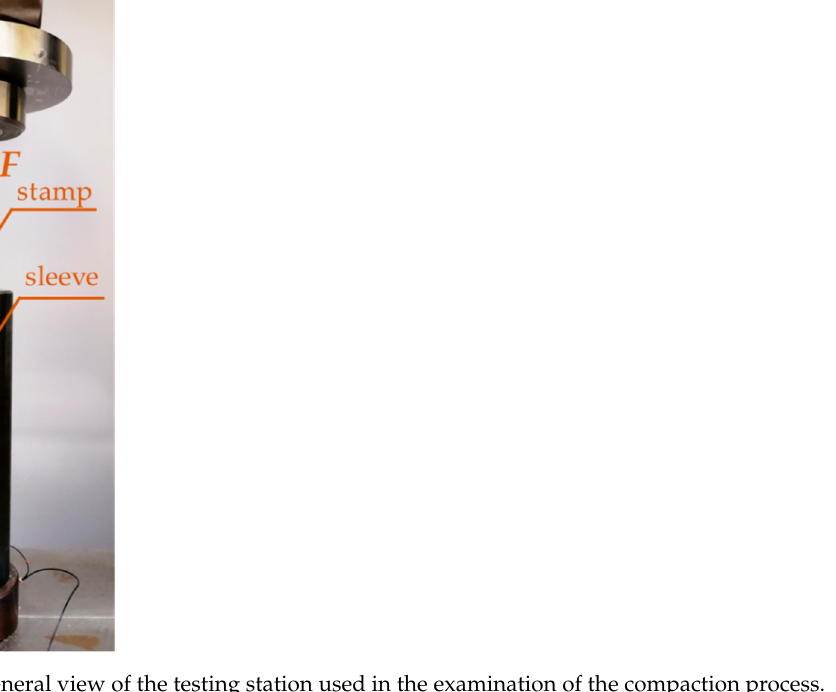
force F registered during compression with an applied force of F = 20,000 N.